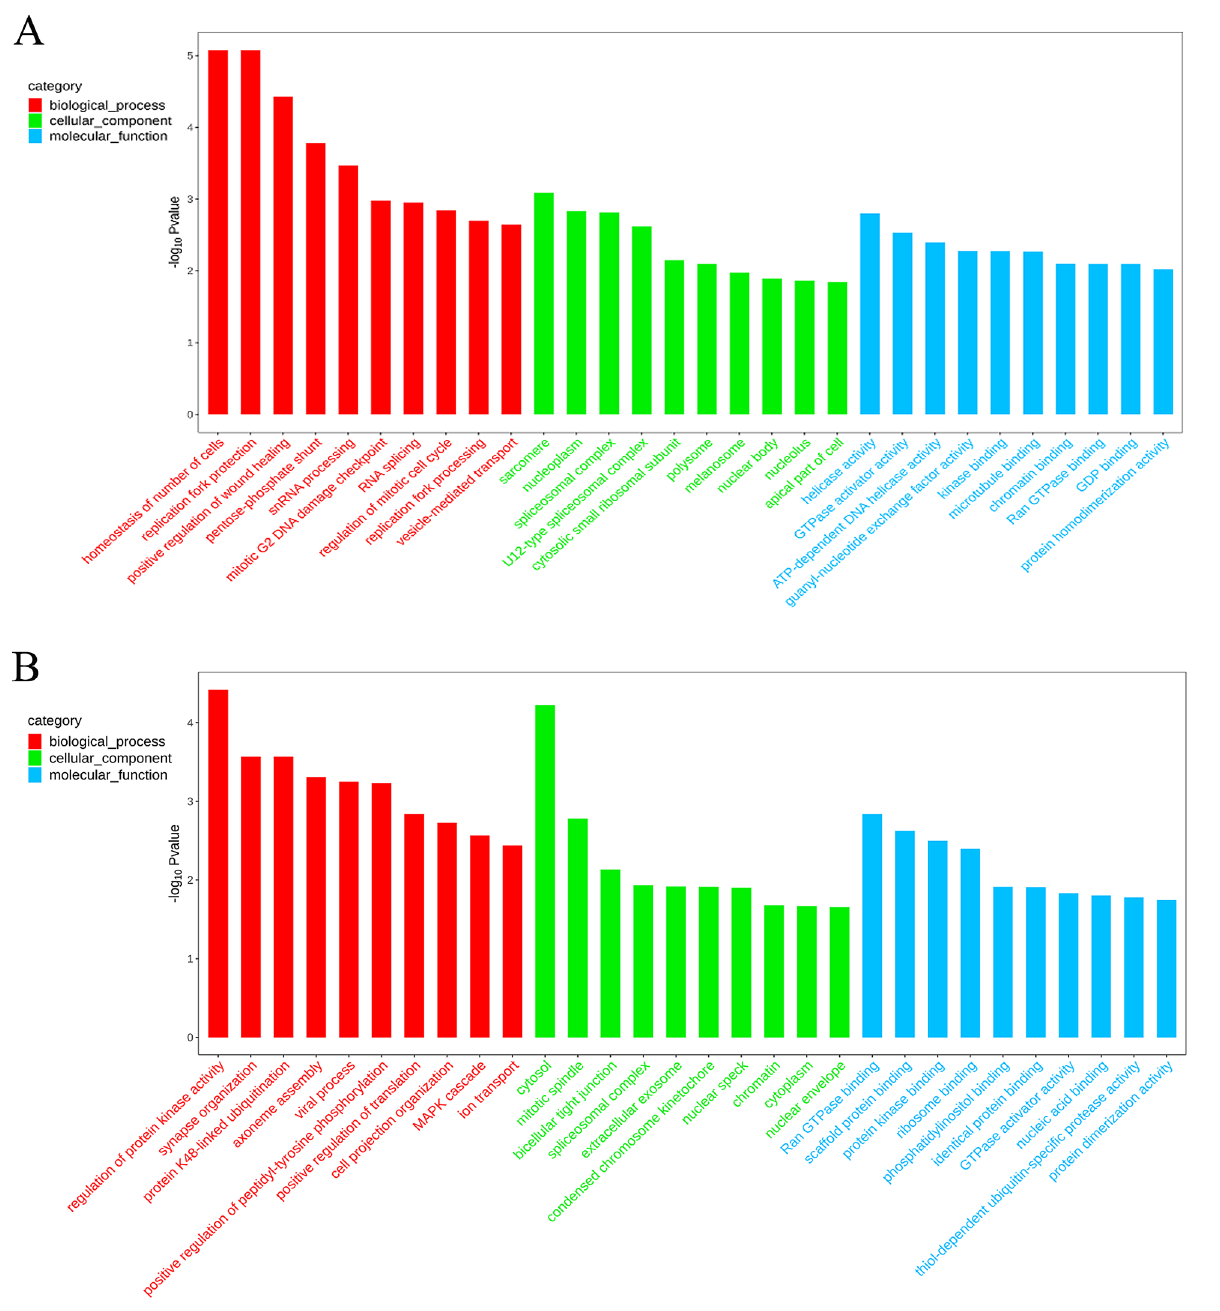
Figure 6. GO functional classification histograms of differentially methylated genes, the X-axis is the GO entry name and the Y-axis is -log10 p -value. ( A : CCGG sites; B : CCWGG